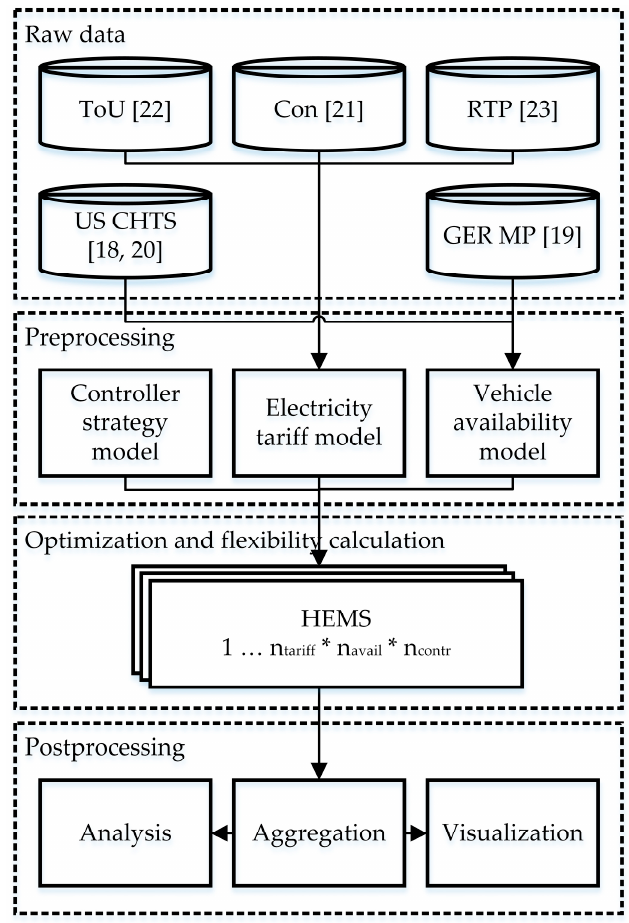
Figure 2. Case study design, US CHTS, and GER MP refers to the Californian and German field trial data used to calculate the vehicle availabilities [18–20]. Con refers to the constant electricity rate in California [21], ToU refers to the ‘ToU-D-Prime’ electricity tari ff of Southern California Edison [22], and RTP refers to the Hourly Real-Time prices of ComEd in Illinois [23], US. n tari ff refers to the number of electricity tari ff s, n avail refers to the number of vehicle availabilities, and n contr refers to the number of controller strategies investigated in this case study.